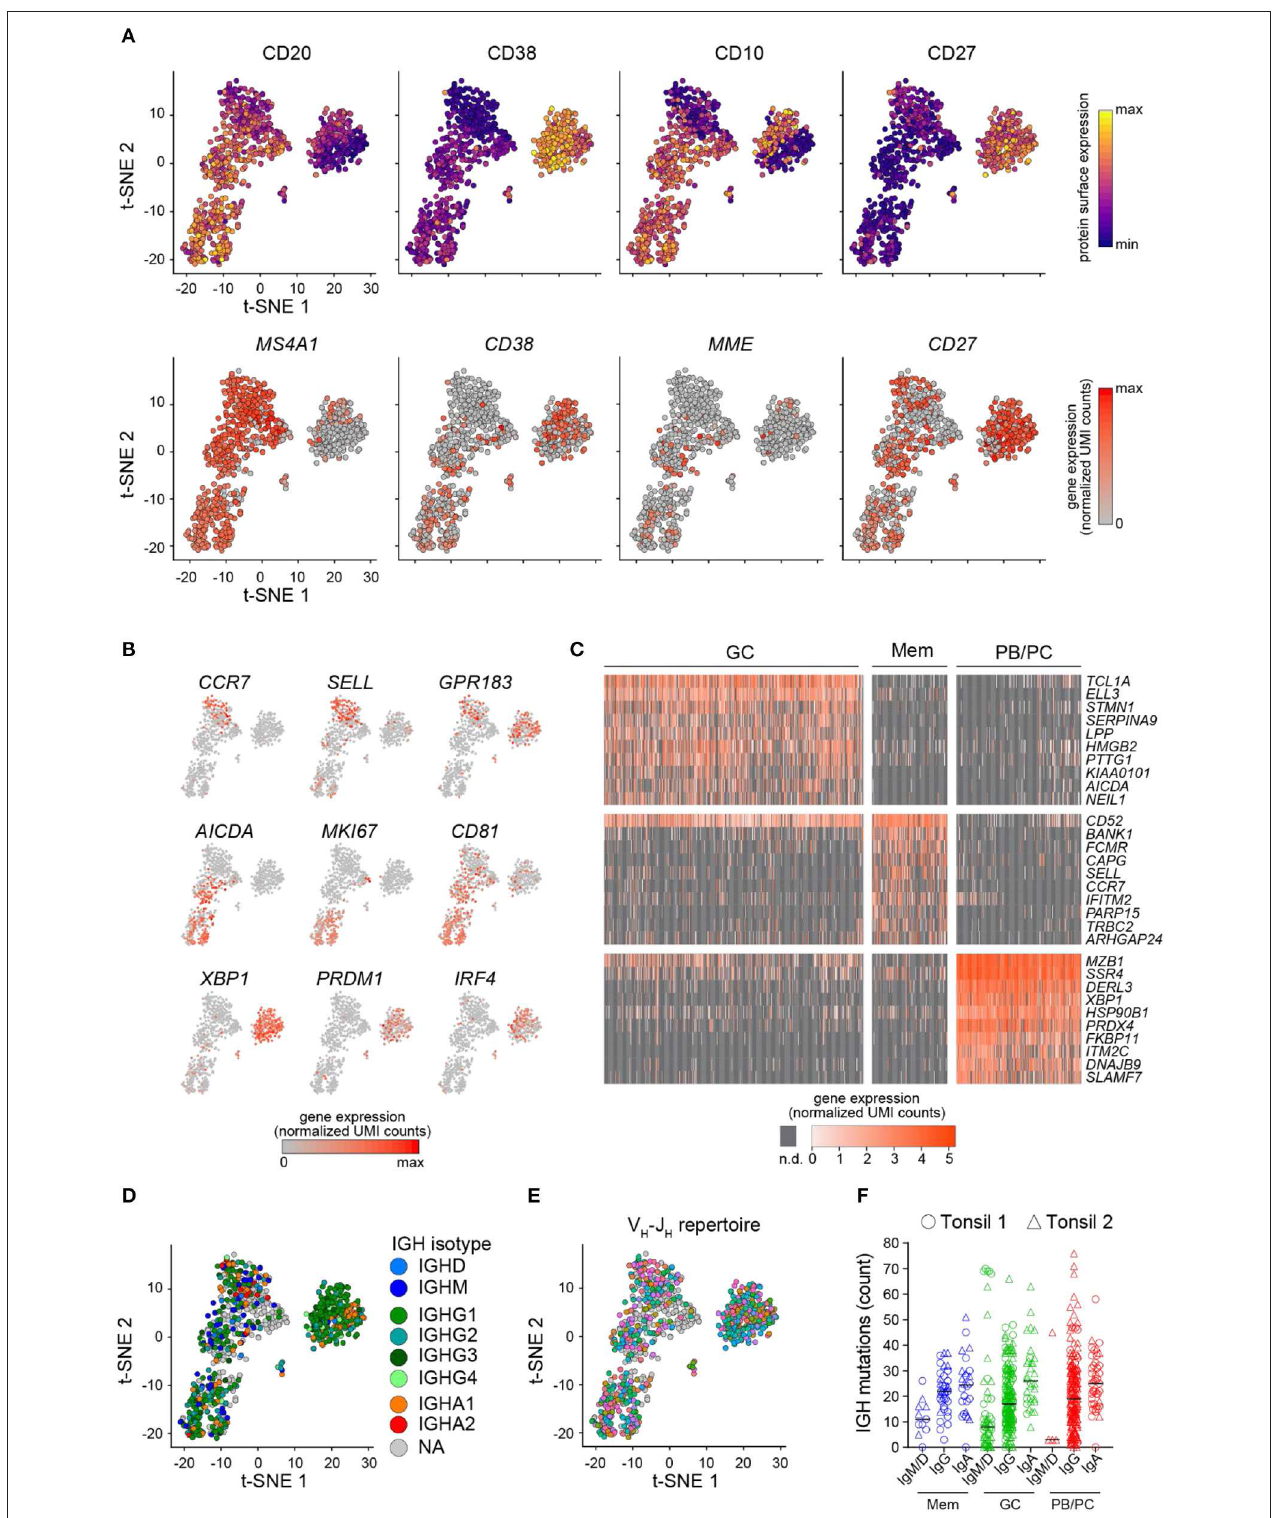
FIGURE 4 | FB5P-seq analysis of human tonsil B cell subsets. (A) t-SNE map of single human tonsil B cell subsets computed on 4,000 variable genes, excluding the BCR genes. The cells are colored based on the surface protein (upper panel) or the corresponding gene (lower panel) expression of the indicated markers ( n = 845 cells). (B) Expression of the indicated marker genes for Mem B cells (upper panel), GC B cells (middle panel), or PB/PCs (bottom panel ) in single human tonsil B cells